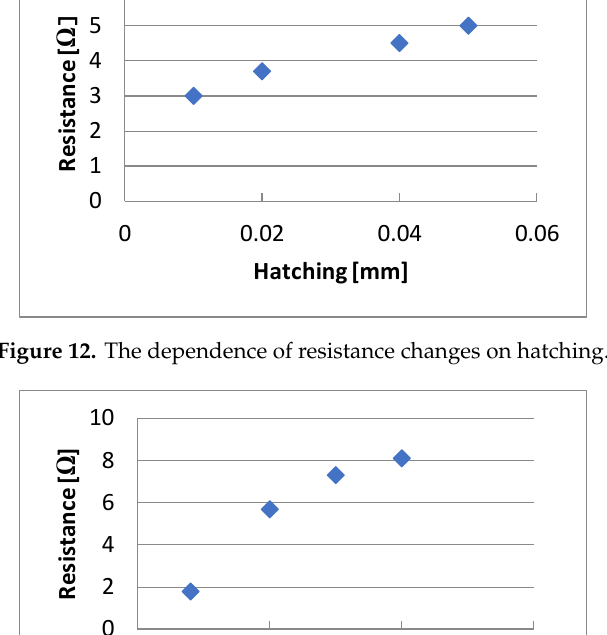
Figure 12. The dependence of resistance changes on hatching.